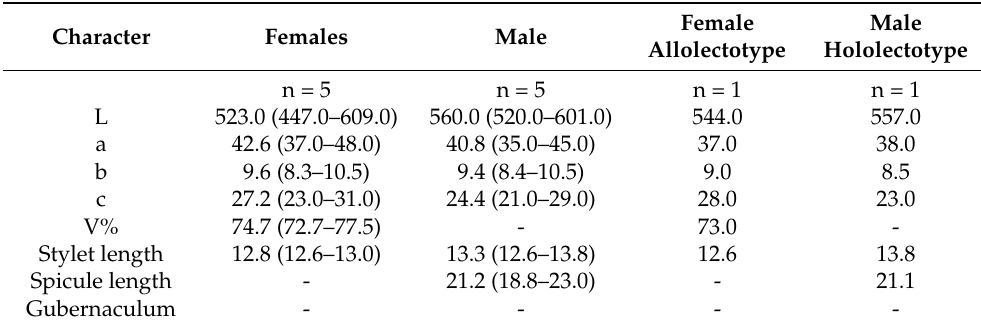
Table 1. Bursaphelenchus xylophilus morphometrics of females and males (after Nickle et al. [27] courtesy of Marcel Decker Inc.).